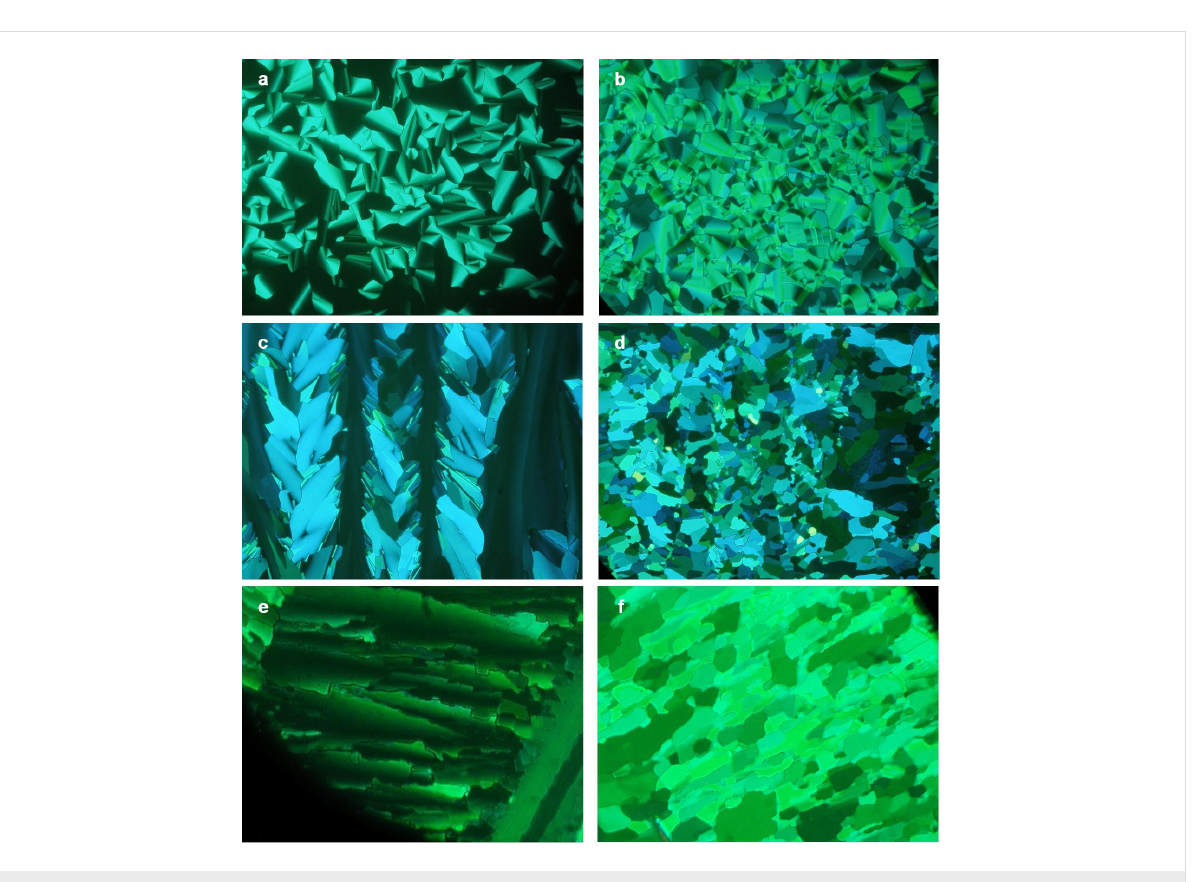
Figure 2: Optical micrographs taken with crossed polarisers and at a magnification of × 20. (a) n -Octyl derivative 7a in the Col h phase at 145 °C. (b) 7a in the Col r phase at 100 °C. (c) Isooctyl derivative 7b in the Col h phase at 170 °C. (d) 7b in the unknown (but probably Cr) phase at 120 °C. (e) Isoheptyl derivative 7c in the Col h phase at 170 °C. (f) 7c in the Cr phase at 155